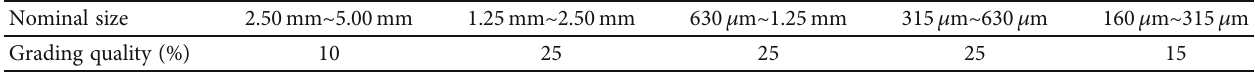
Table 3: Sand grade